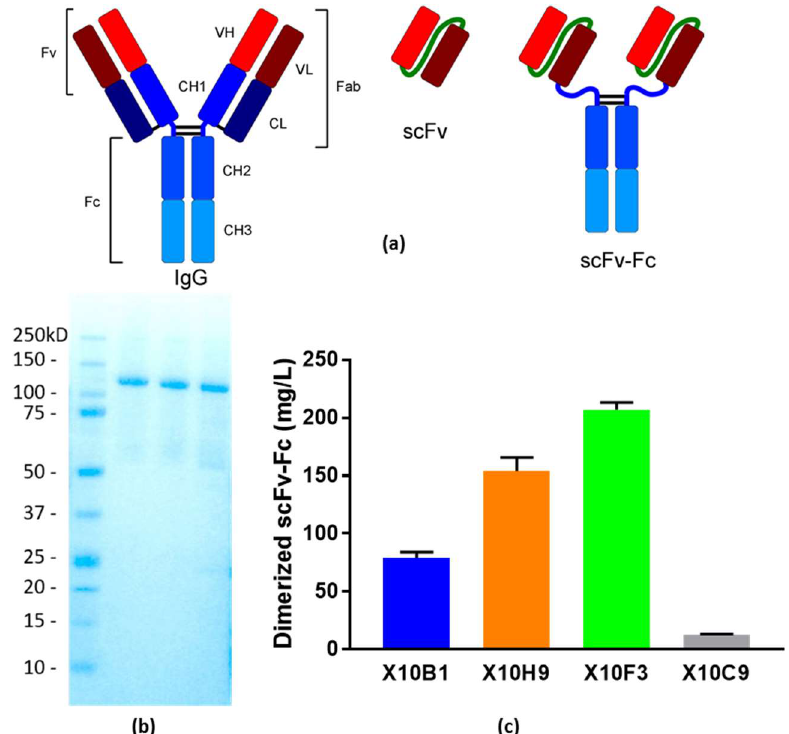
Figure 3. Cell-free expression of candidate scFv-Fc antibody fragments. ( a ) Representation of the structure of the three antibody fragments utilized in this study. The typical IgG format is shown on the left, the scFv format utilized for binding and neutralization in the center, and the scFv-Fc format utilized in neutralization and protection studies on the right. ( b ) Coomassie stained SDS-PAGE Gel of purified scFv-Fcs. Precision Plus Protein™ Standards (BioRad, Hercules, CA, USA); Lane 2: X10F3; Lane 3: X10H2; Lane 4: X10B1. ( c ) Titers from the cell-free expression of the candidate scFv-Fcs.